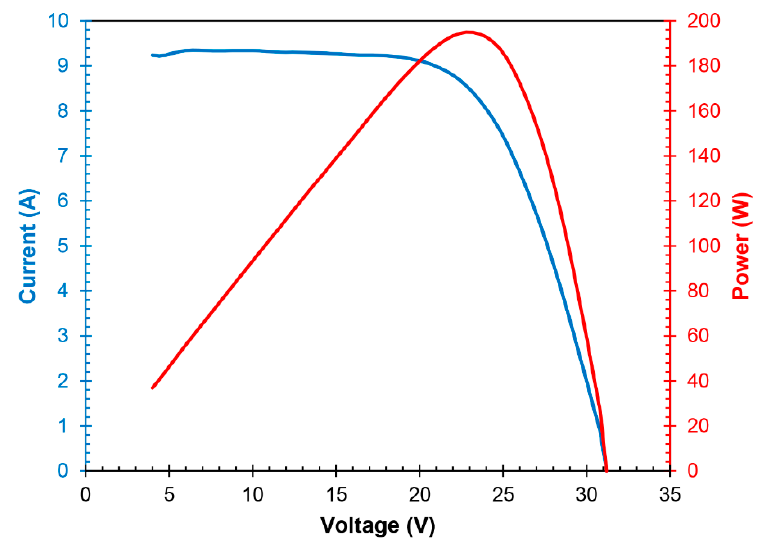
Figure 9. Measured I-V curve at T PV = 59.2 ◦ C and G s = 1000 W m − 2 , for the PV modules used in this work.